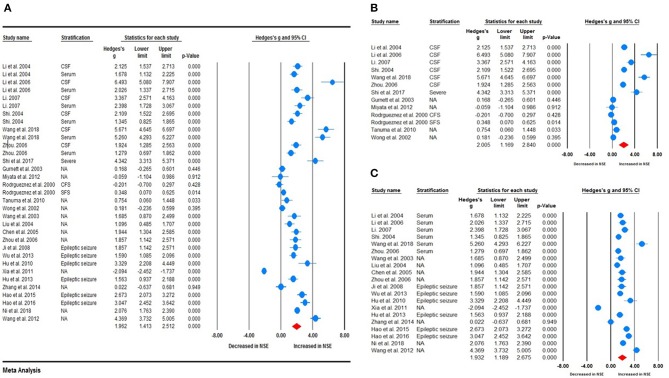
Forest plot illustrating the association between neuron-specific enolase (NSE) levels and epilepsy in children. (A) Forest plot illustrating the NSE levels in cerebrospinal fluid and serum in children with epilepsy. (B) Forest plot illustrating the association between NSE levels in cerebrospinal fluid (CSF) and epilepsy in children. (C) Forest plot illustrating the association between NSE levels in serum and epilepsy in children. The sizes of the circles are proportional to study weights. The diamond marker indicates pooled effect size (ES).